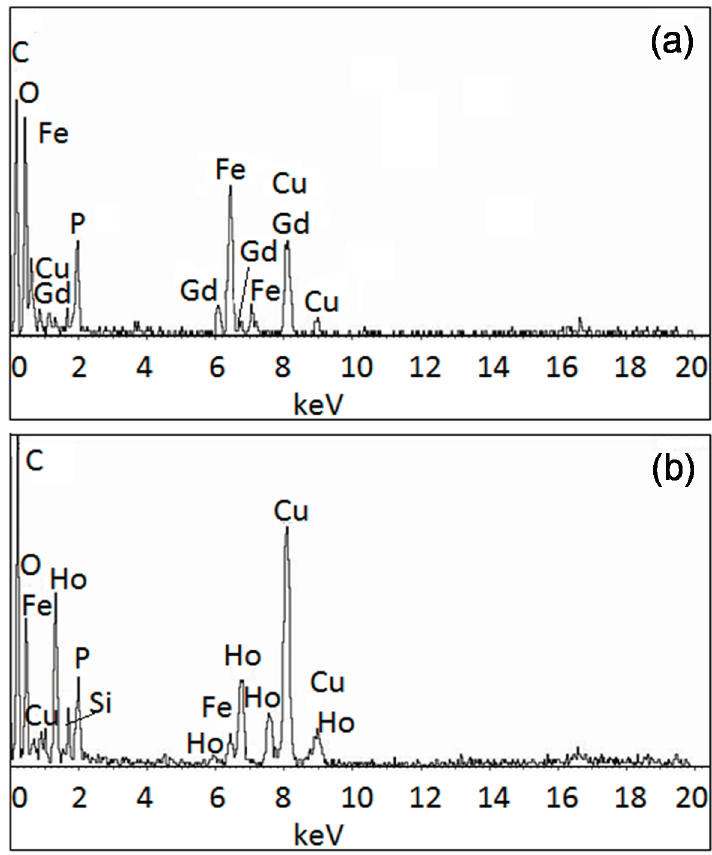
Figure 7. TEM/EDX analysis of the enzymatically-synthesized ( a ) Fe–Gd–O and ( b ) Fe–Ho–O magnetic